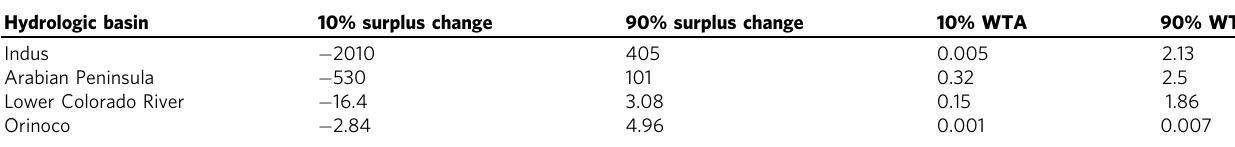
Table 1 Quantiles of surplus change and physical water scarcity in the four selected basins (billions US 2020$). Hydrologic